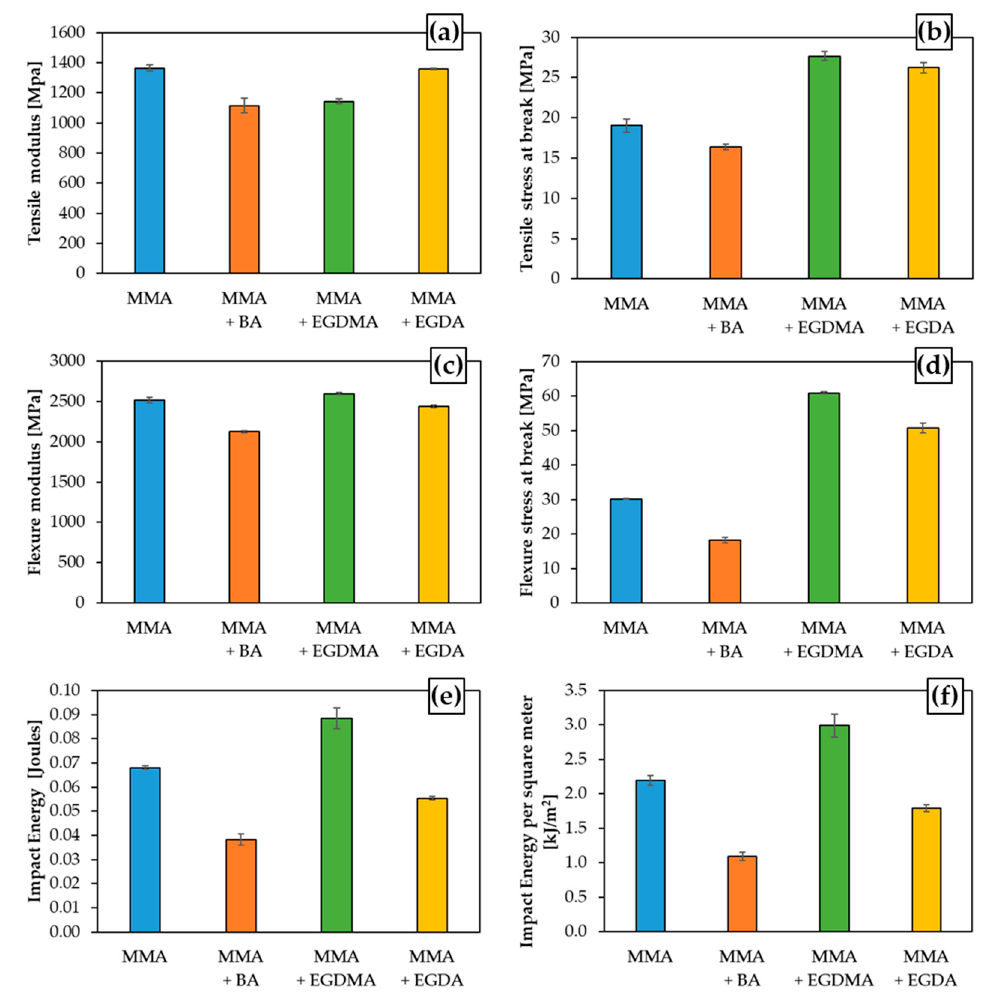
Figure 7. Results of mechanical screening testing, considering the same cases as for the rheological analysis in Figure 6 (see also Table 1): ( a ) Tensile modulus in MPa, ( b ) Tensile stress at break in MPa, ( c ) Flexure modulus in MPa, ( d ) Flexure stress at break in MPa, ( e ) Impact energy in joules; ( f ) Impact energy per square meter at the impact face. The color coding is introduced in Figure 4. Images of broken test samples are provided in the Supporting Information, which also includes the raw data for Figure 7 before statistical averaging.